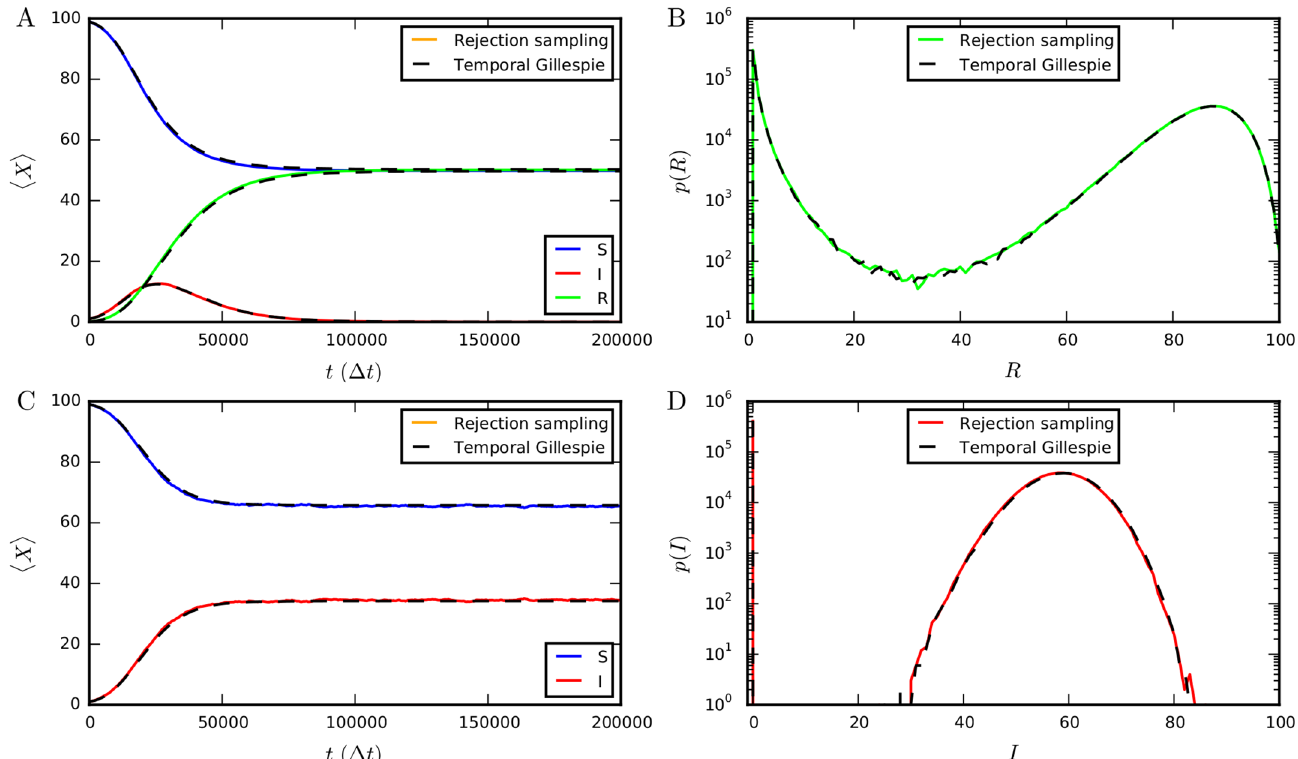
Fig 3. Comparison of numerical results from temporal Gillespie and rejection sampling algorithms. (A) Mean number of nodes in each state of the SIR model as function of time. (B) Distribution of final epidemic sizes (number of recovered nodes when I = 0) in the SIR model. (C) Mean number of nodes in each state of the SIS model as function of time. (D) Distribution of the number of infected nodes in the stationary state ( t ! 1 ) of the SIS model. All simulations were performed 1 000 000 times with the root node chosen at random on an activity driven network [41] consisting of N = 100 nodes, with activities a i = η z i , where η = 0.1 and z i (cid:4) z (cid:5) 3 : 2 i for z i 2 [0.03, 1), and a node formed two contacts when active. Parameters of the epidemic processes were β Δ t = 10 − 2 and μ Δ t = 10 − 4 .